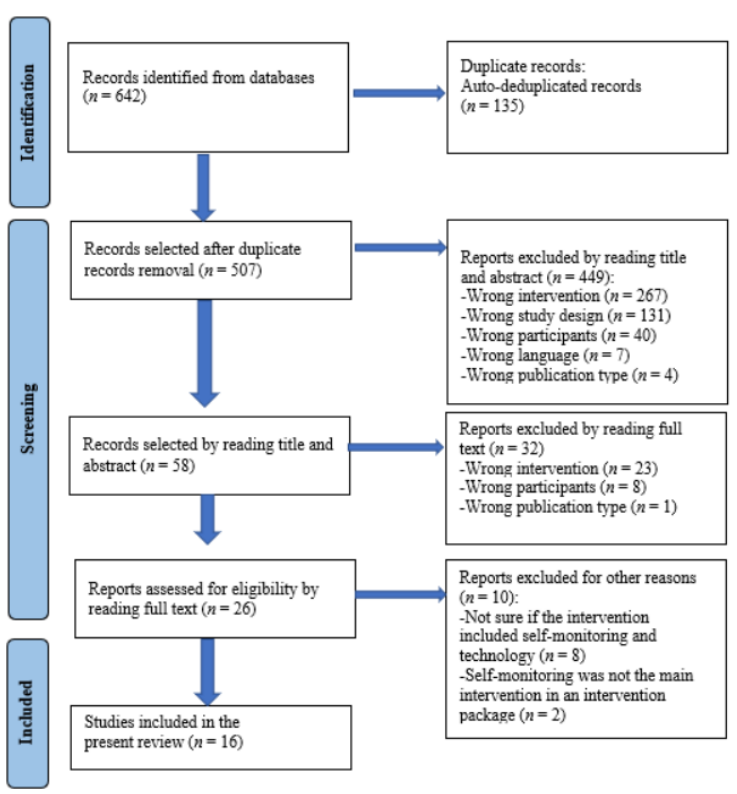
Figure 1. Article identification and screening process (adapted from the PRISMA flow diagram (Page, et al. [23]).